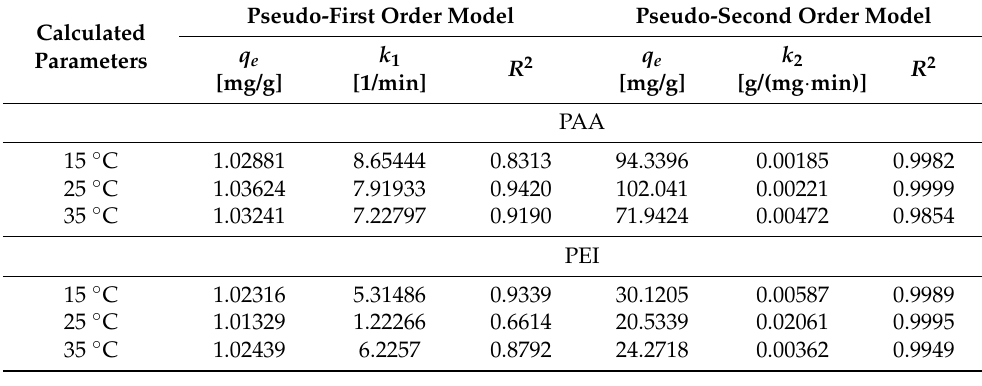
Table 3. Kinetic parameters of the PAA/PEI adsorption on the NE–AC activated carbon.